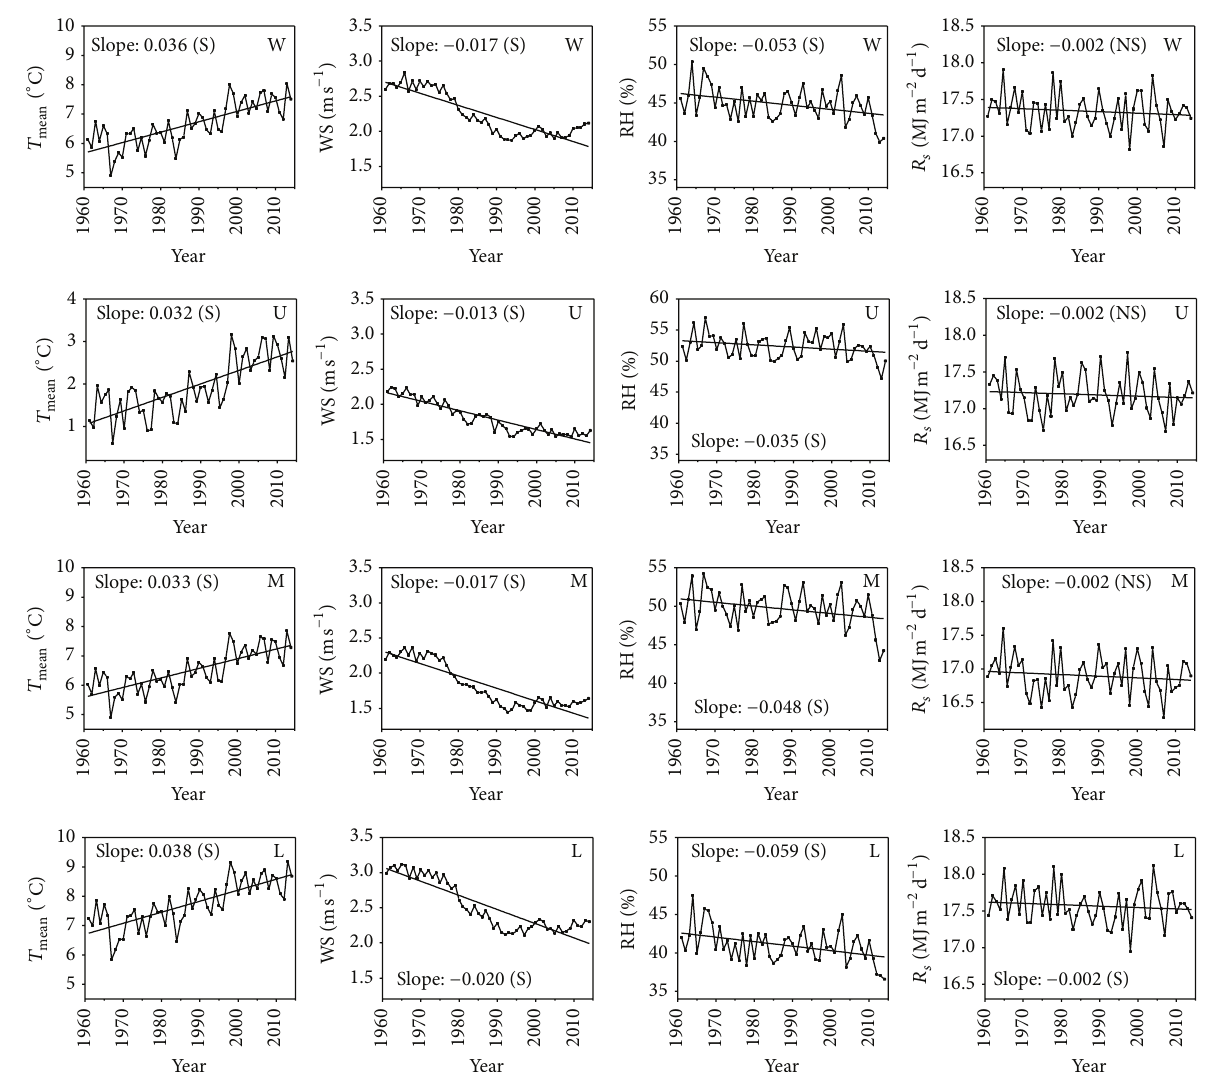
Figure 8: Trends of annual 𝑇 mean , WS, RH, and 𝑅 𝑠 for the upper (U), middle (M), and lower (L) region and the whole basin (W). S indicates that the trend is statistically significant, and NS indicates that the trend is not significant at the 0.05 level.